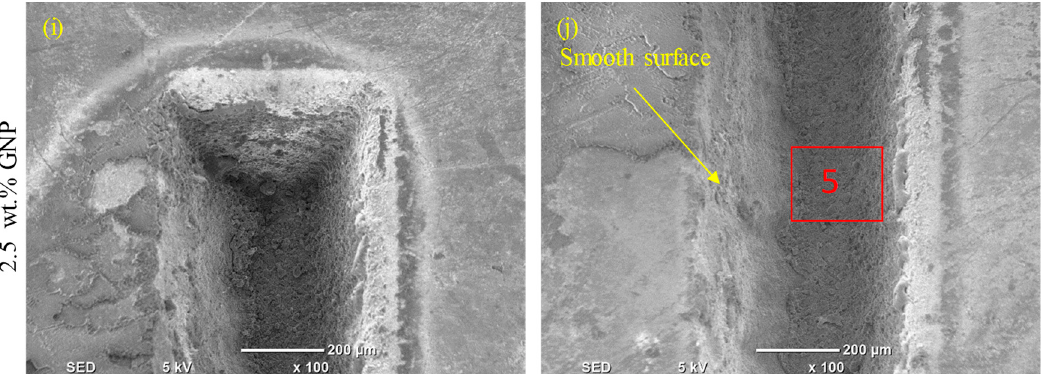
Figure 9. Surface morphology of the ablated base Al 2 O 3 and GNP/Al 2 O 3 nanocomposites with varying graphene contents at 200 mm/s.